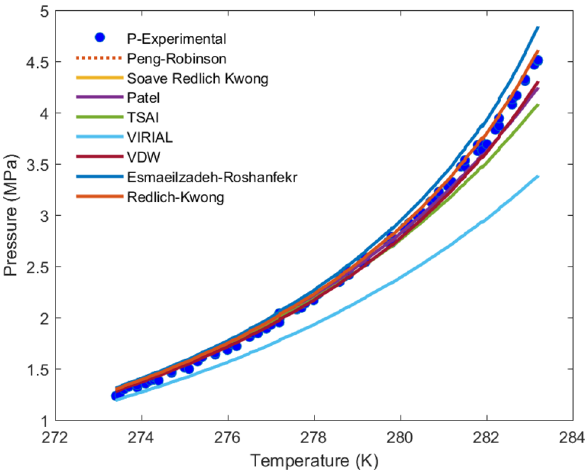
H – V phase Fig. 10 Predicted pressure versus experimental plot for L w – phase region, AAD %, [Min/Max] of